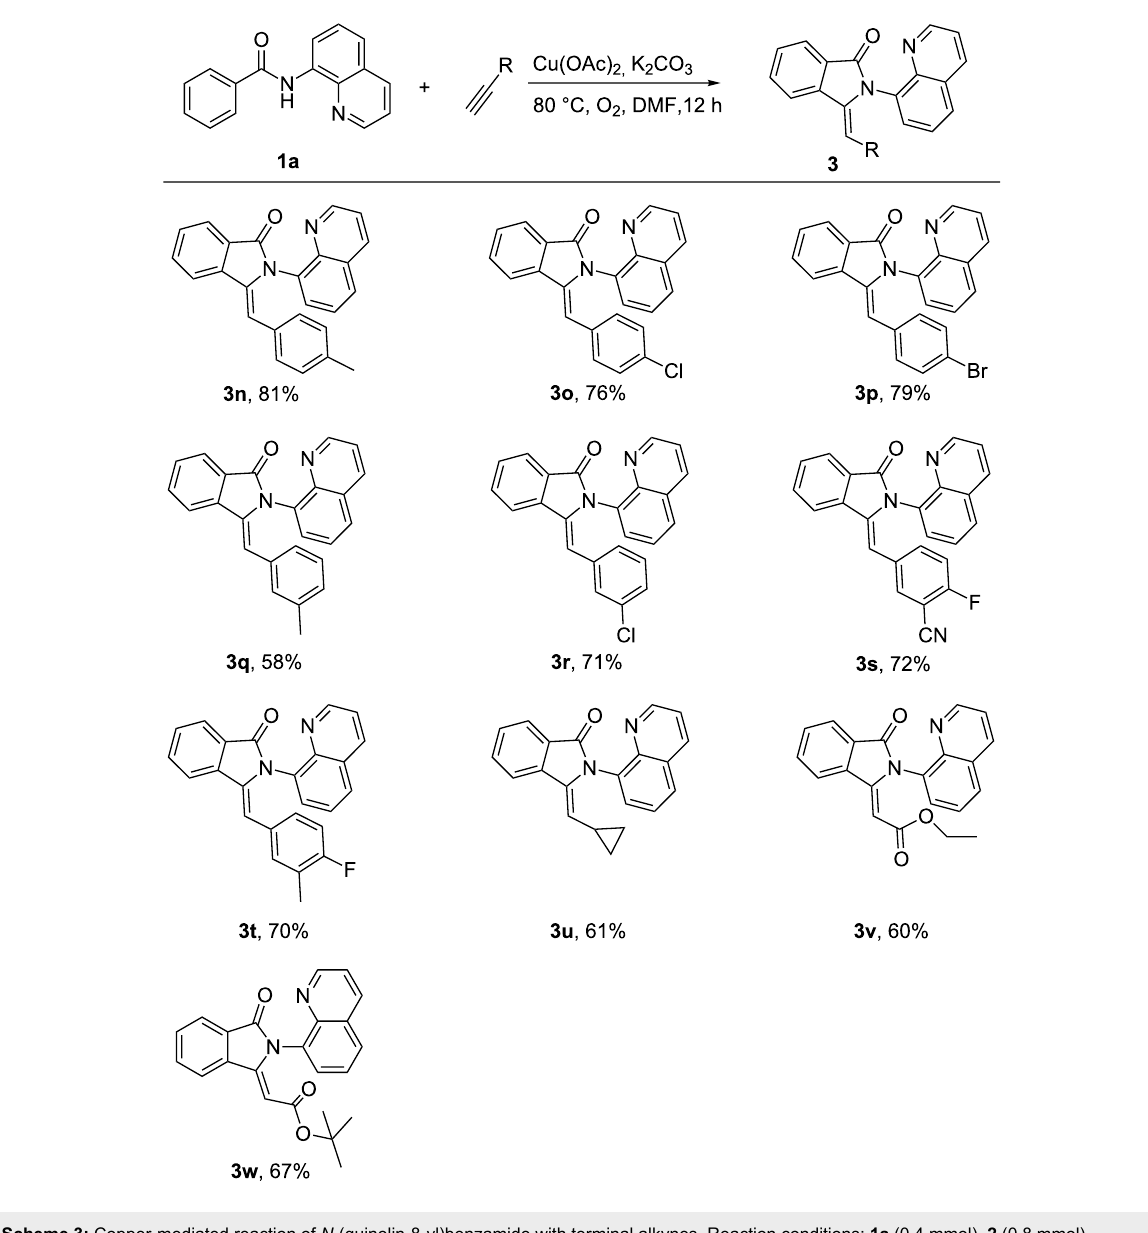
Scheme 3: Copper-mediated reaction of N -(quinolin-8-yl)benzamide with terminal alkynes. Reaction conditions: 1a (0.4 mmol), 2 (0.8 mmol),